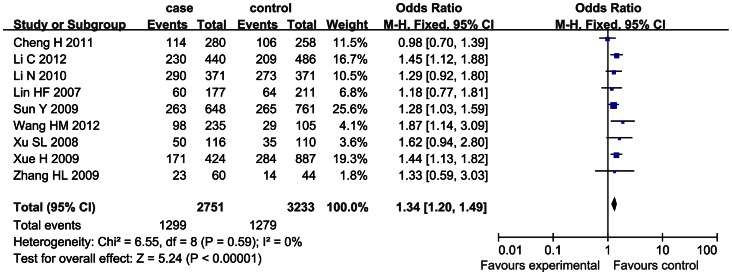
Forrest plot on the association between SNP 83 and ischemic stroke under the dominant model (CC+CT/TT).